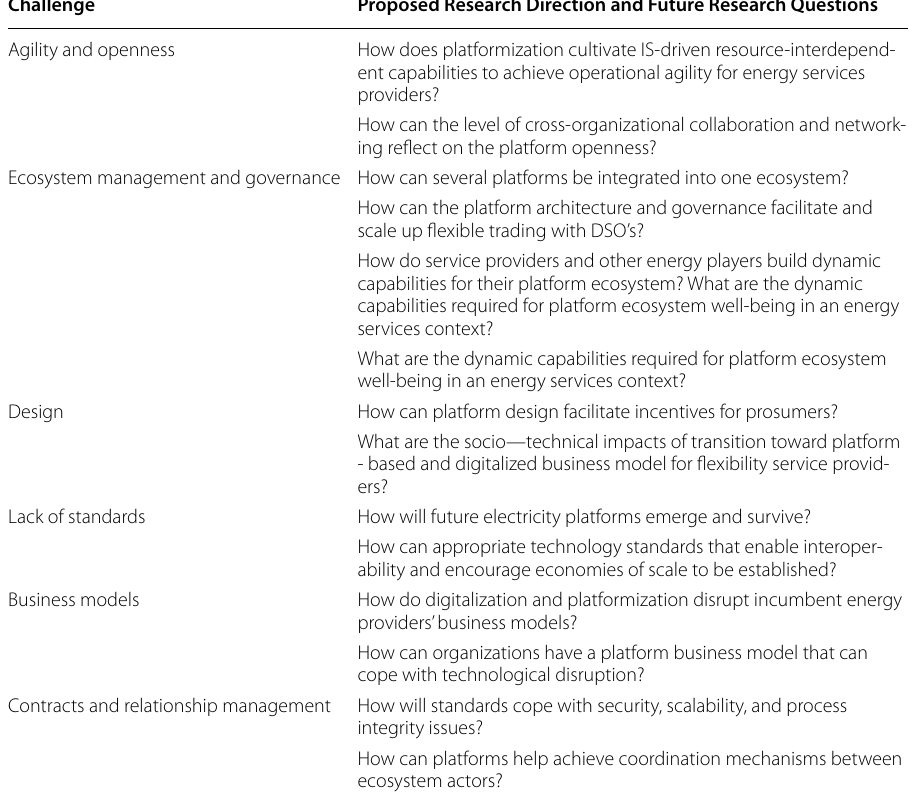
Table 5 Proposed research directions and future research questions Challenge Proposed Research Direction and Future Research